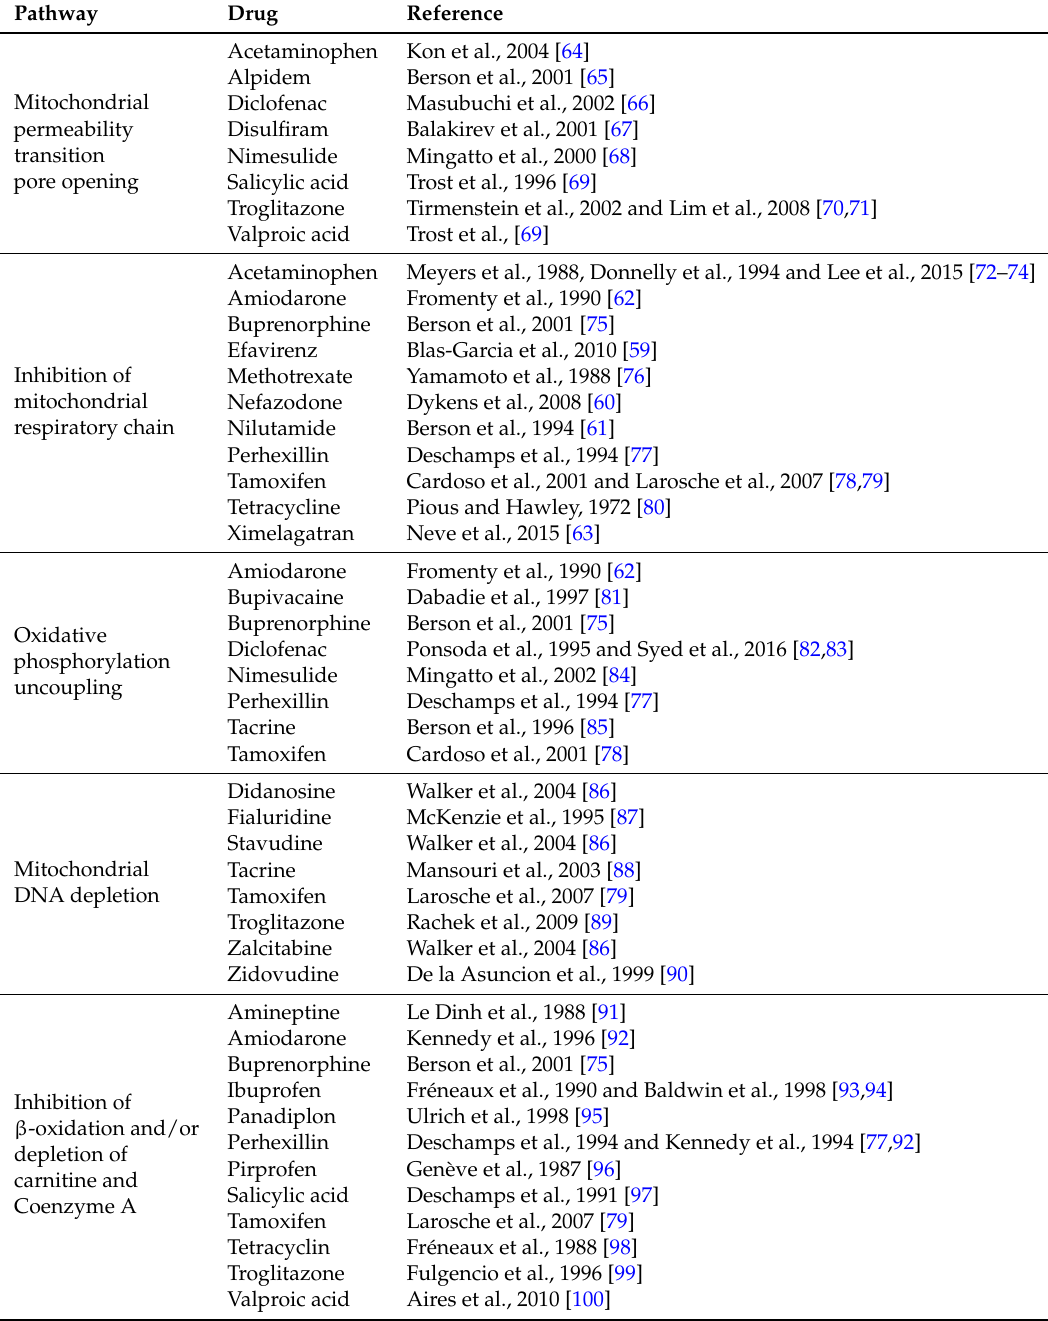
Table 3. References describing the mitochondrial effect of the drugs highlighted in Figure